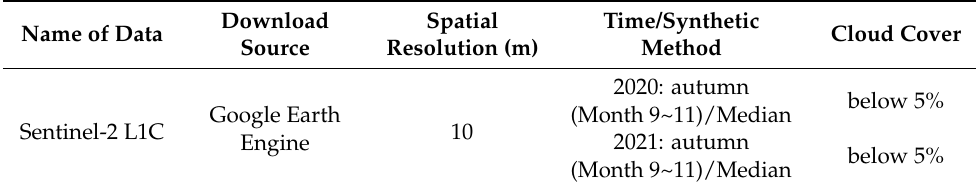
Table 1. Optical image sources.